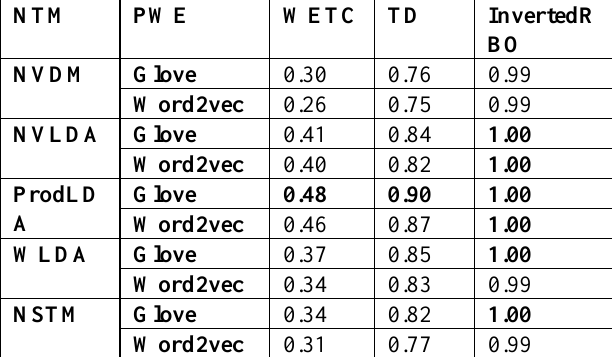
Table 4. The WETC and TD for different models on the French dataset.